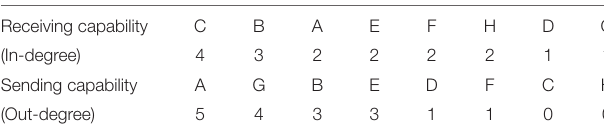
TABLE 2 | The order of nodes’ receiving and sending capability.